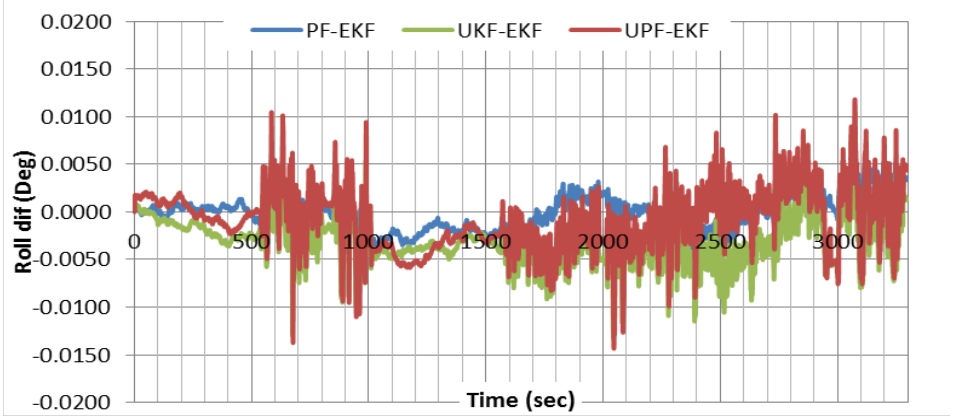
Figure 7. Comparison of roll component results obtained through various estimation